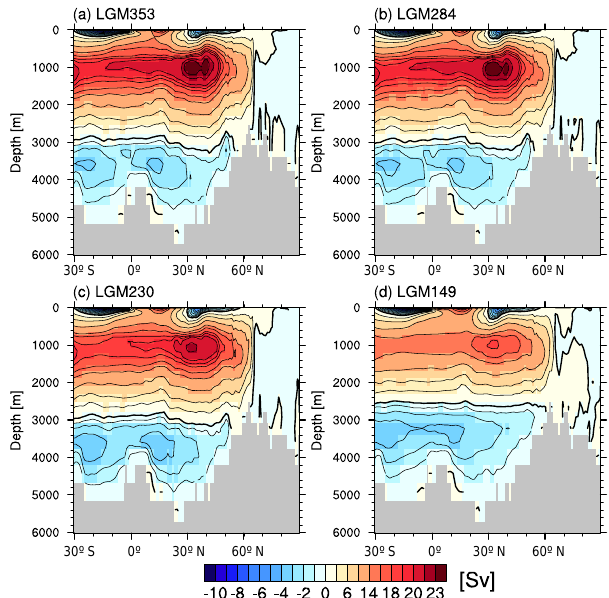
Figure 8. Atlantic meridional overturning stream function for (a) LGM353, (b) LGM284, (c) LGM230 and (d) LGM149. Red shading indicates clockwise, and blue shading indicates anticlock- wise flow. Note that the contour levels are not